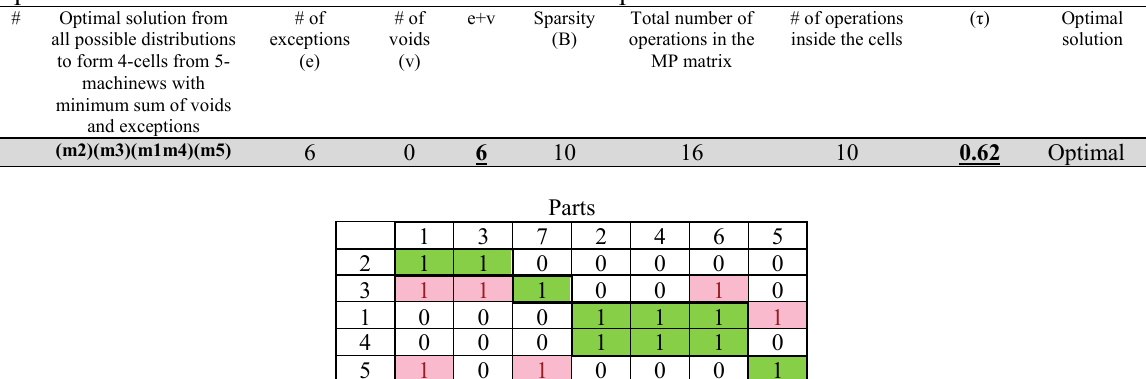
Fig. 11. Optimal 4-cell solution with minimum sum of voids and